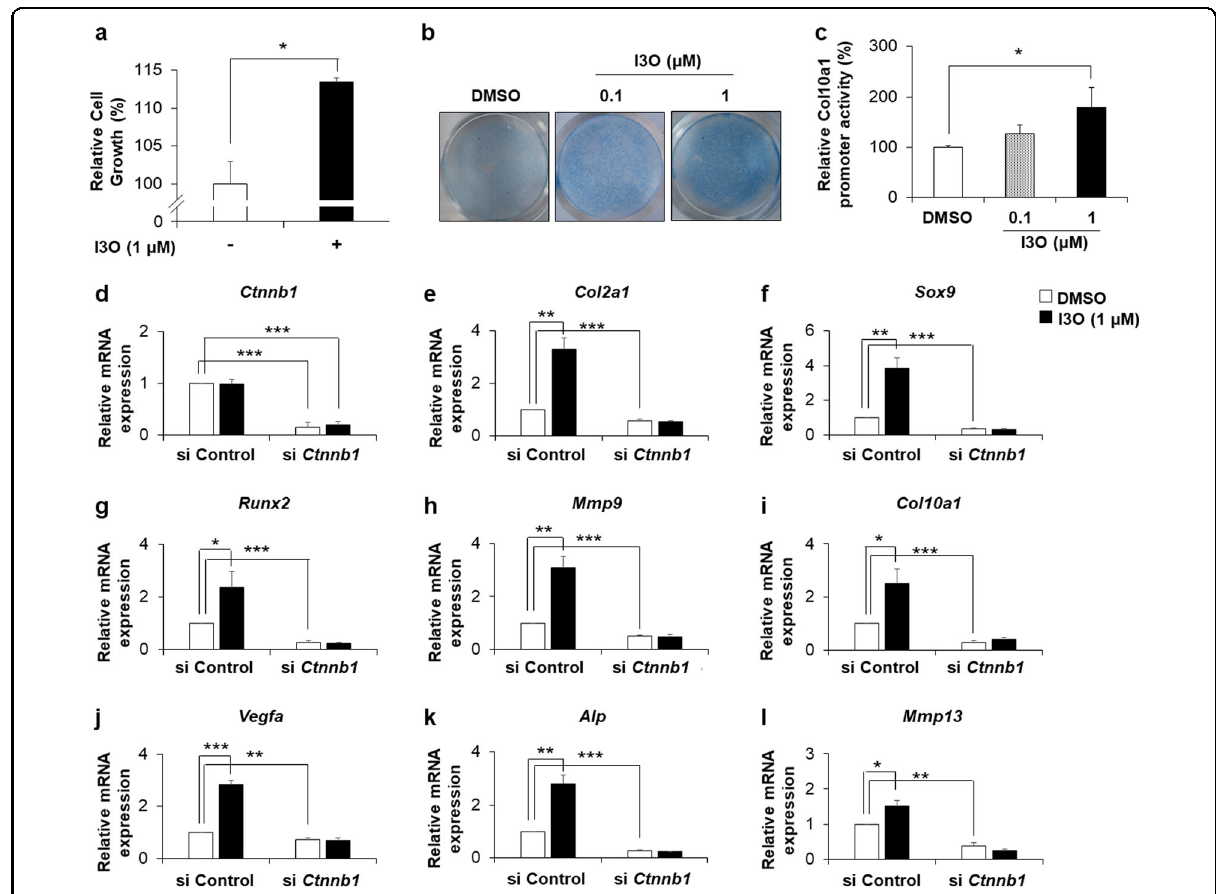
Fig. 3 The effects of I3O on chondrocyte proliferation and differentiation via activation of the Wnt/ β -catenin pathway. a ATDC5 cells were treated with 1 μ M of I3O for 48 h, and cell growth was assessed by the 3-(4,5-dimethylthiazol-2-yl)-2,5-diphenyltetrazolium bromide (MTT) assay (mean± s.e.m., n = 3 per group, * P < 0.05). b RCS cells treated with DMSO or I3O were subjected to Alcian blue staining. c Col10a1 promoter activity was analyzed by treatment with 1 μ M I3O in ATDC5 cells transfected with a luciferase reporter gene construct containing a cloned 4.5-kb promoter fragment of COL10 (mean± s.e.m., n = 3 per group, * P < 0.05). d – l ATDC5 cells transfected with control siRNA or Ctnnb1 siRNA were treated with or without 1 μ M I3O for 72 h in three-dimensional alginate beads. The relative mRNA levels of chondrogenic differentiation markers were measured by qRT-PCR (mean± s.e.m., n = 3 per group, * P < 0.05, ** P < 0.005, and *** P <